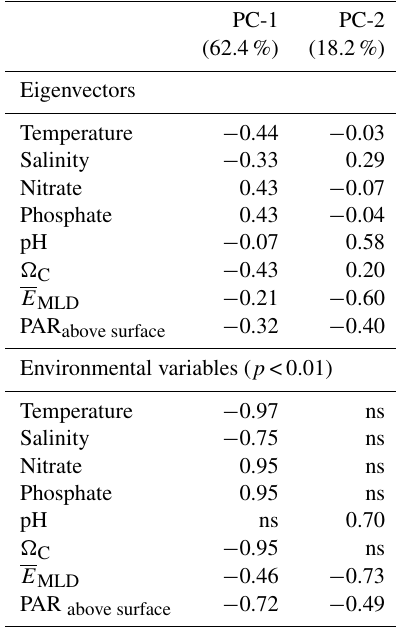
Table 1. Principal component (PC) analysis and Pearson product moment correlations between PC scores and environmental vari- ables. ns indicates not